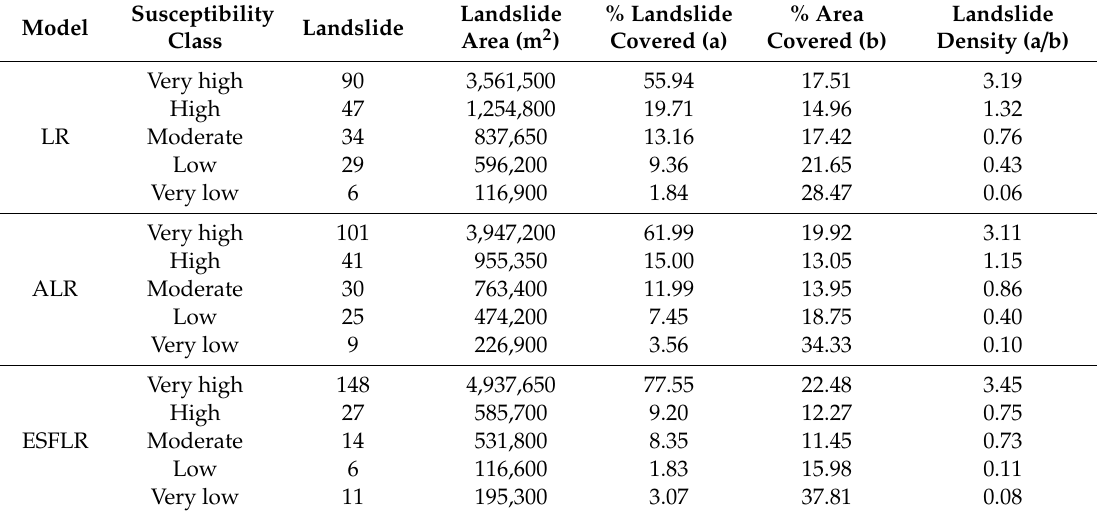
Table 11. Validation of landslide susceptibility maps obtained by the LR, ALR and ESFLR models. Landslide % Landslide Susceptibility Landslide Model Area (m 2 ) Covered Class